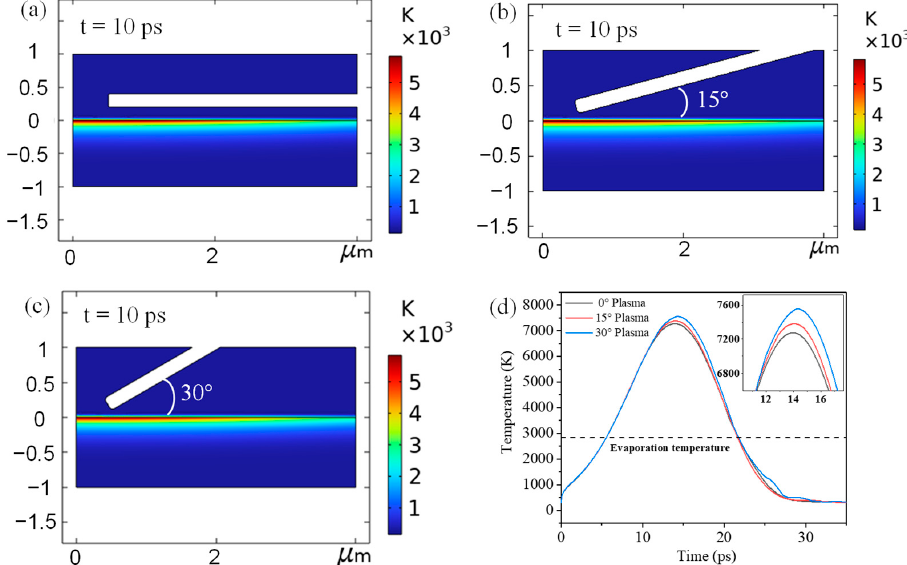
Figure 2. Lattice temperature distribution of Cu film at 10 ps after being irradiated by a single − pulse 1.0 J/cm 2 ps − laser with different plasma action angles: ( a ) 0°, ( b ) 15° and ( c ) 30°. ( d ) Evolution of lattice temperatures with time in Cu irradiated by single − pulse 1.0 J/cm 2 ps − laser with different plasma action angles.